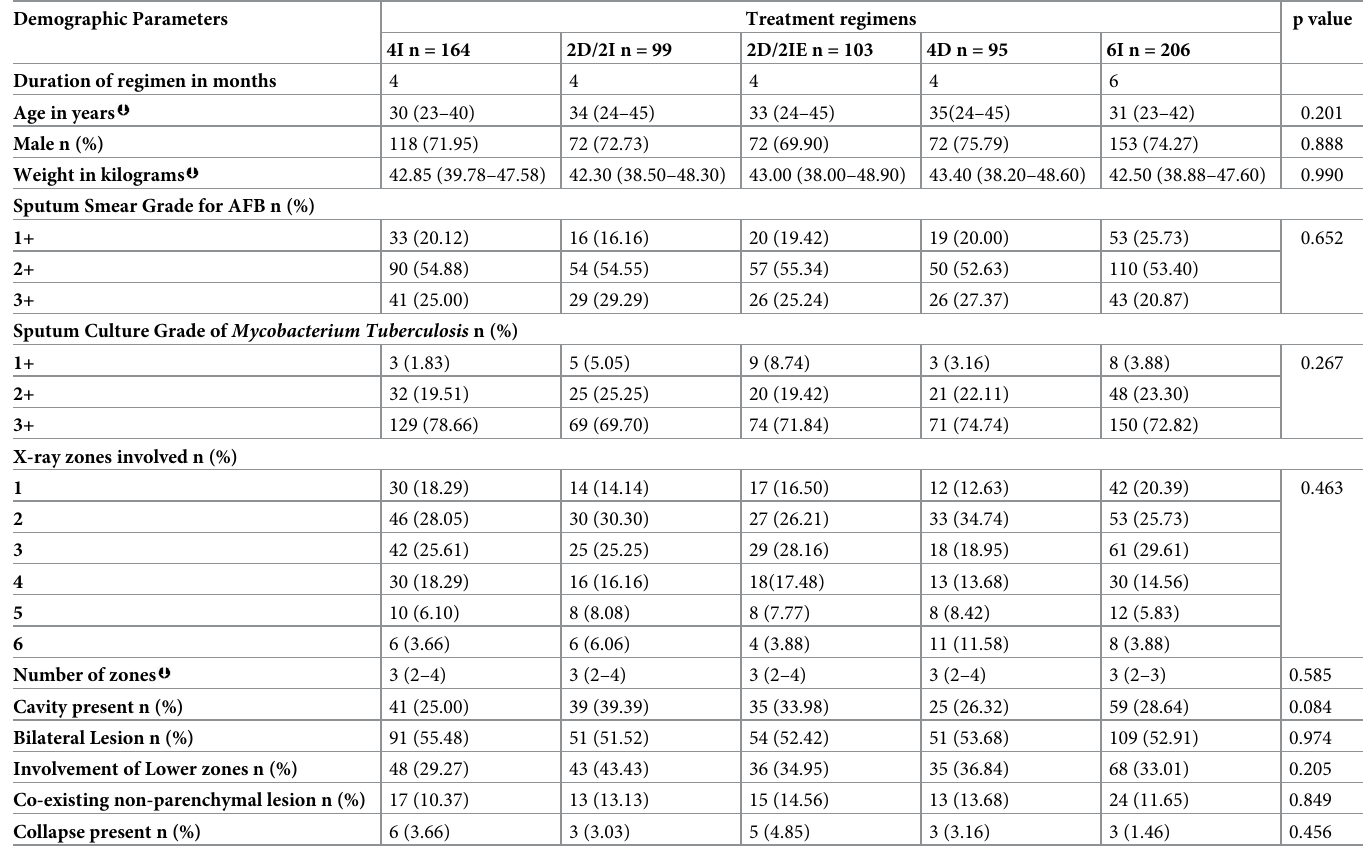
Table 1. Baseline characteristics of trial participants (n = 667), segregated by